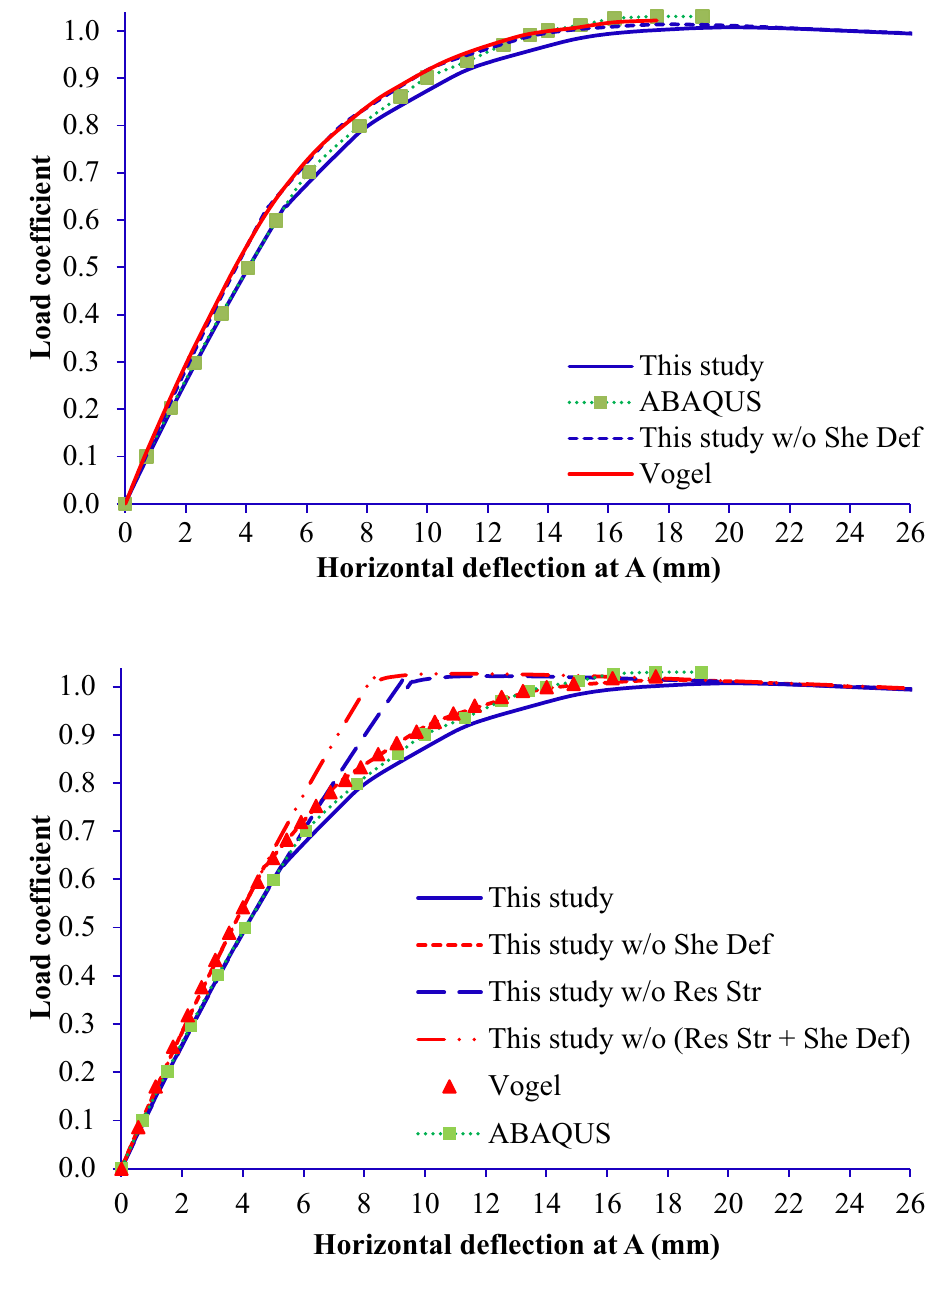
Fig. 5 Load–deflection rela- tionship at A of portal frame